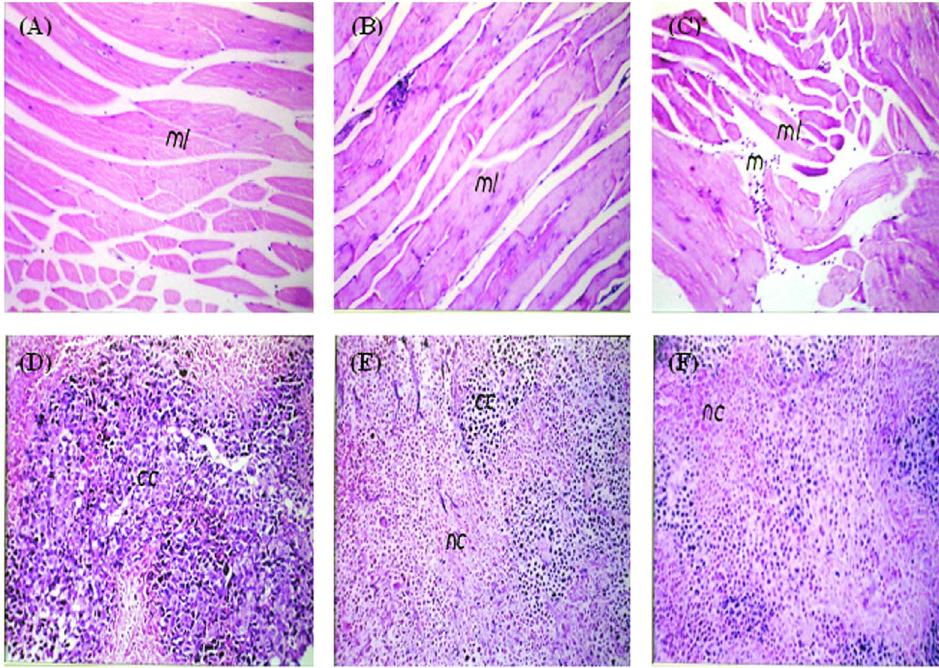
Figure 7. Photomicrograph of skeletal muscles and ESC of mice. (A, B) Muscles from control group and group injected IP with MNPs showing intact normal histological structure (ml). (C) Muscles injected IM with MNPs have focal inflammatory cells infiltration (m) in between the muscle bundles (ml). (D) Untreated tumor showing intact cancer cells (cc) occupying 90% of the skeletal muscle bundles with only 20% necrosis. (E) IP injected MNPs induced 40% necrosis (nc) of the injected Ehrlich tumor cells. (F) IT injected MNPs induced 60% necrosis (nc). H&E 6 40